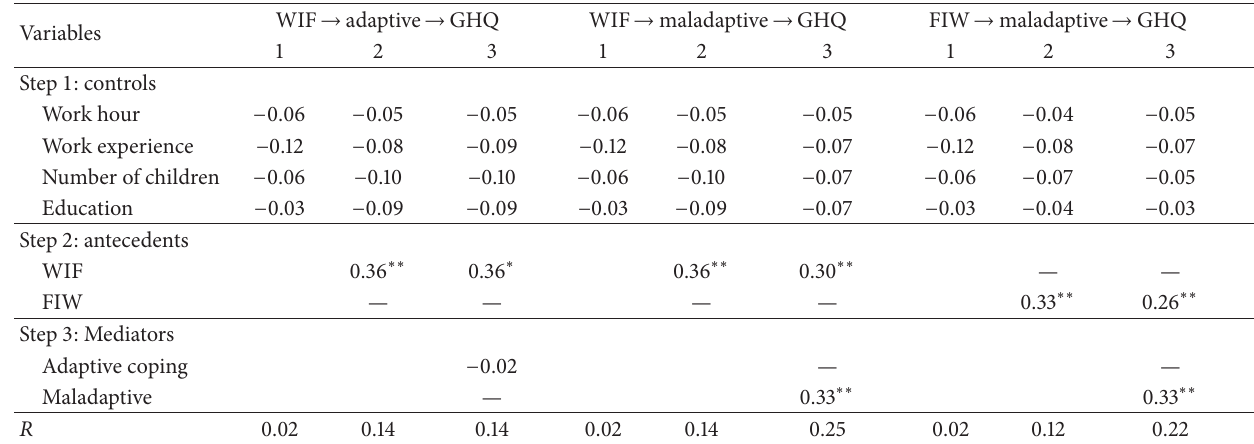
Table 3: Linear regression